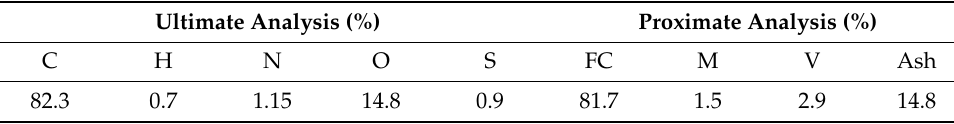
Table 3. The ultimate and proximate analysis of